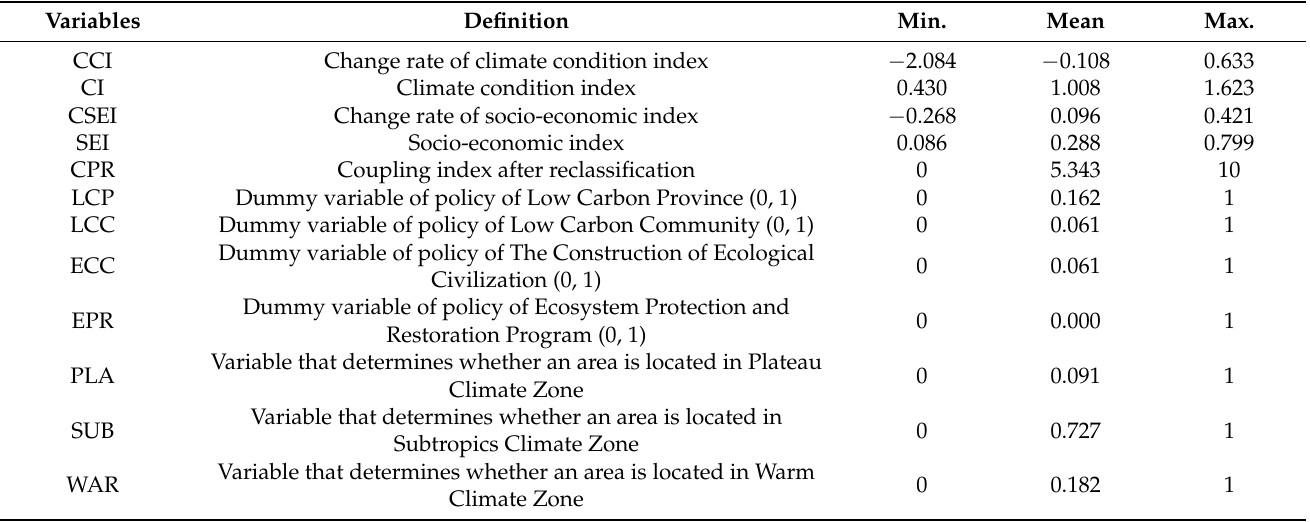
Table 4. Descriptive statistics of variables.